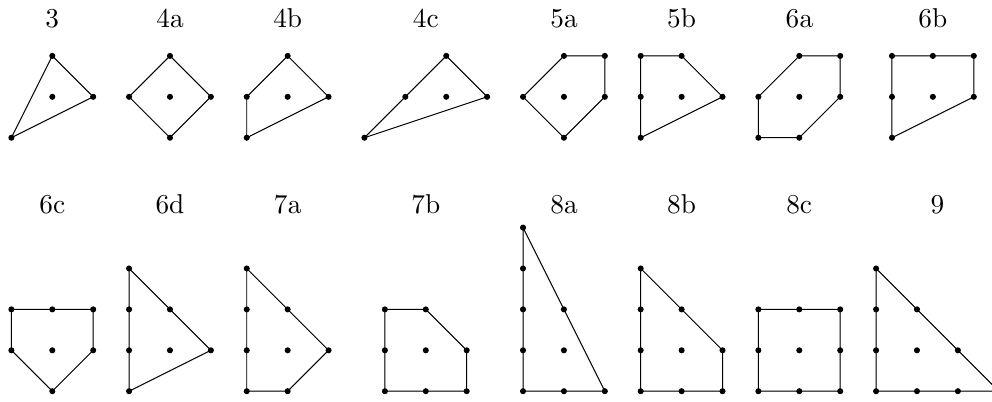
Figure 1 . List of Newton polygons with a single internal point and 3 (cid:20) B (cid:20) 9 boundary